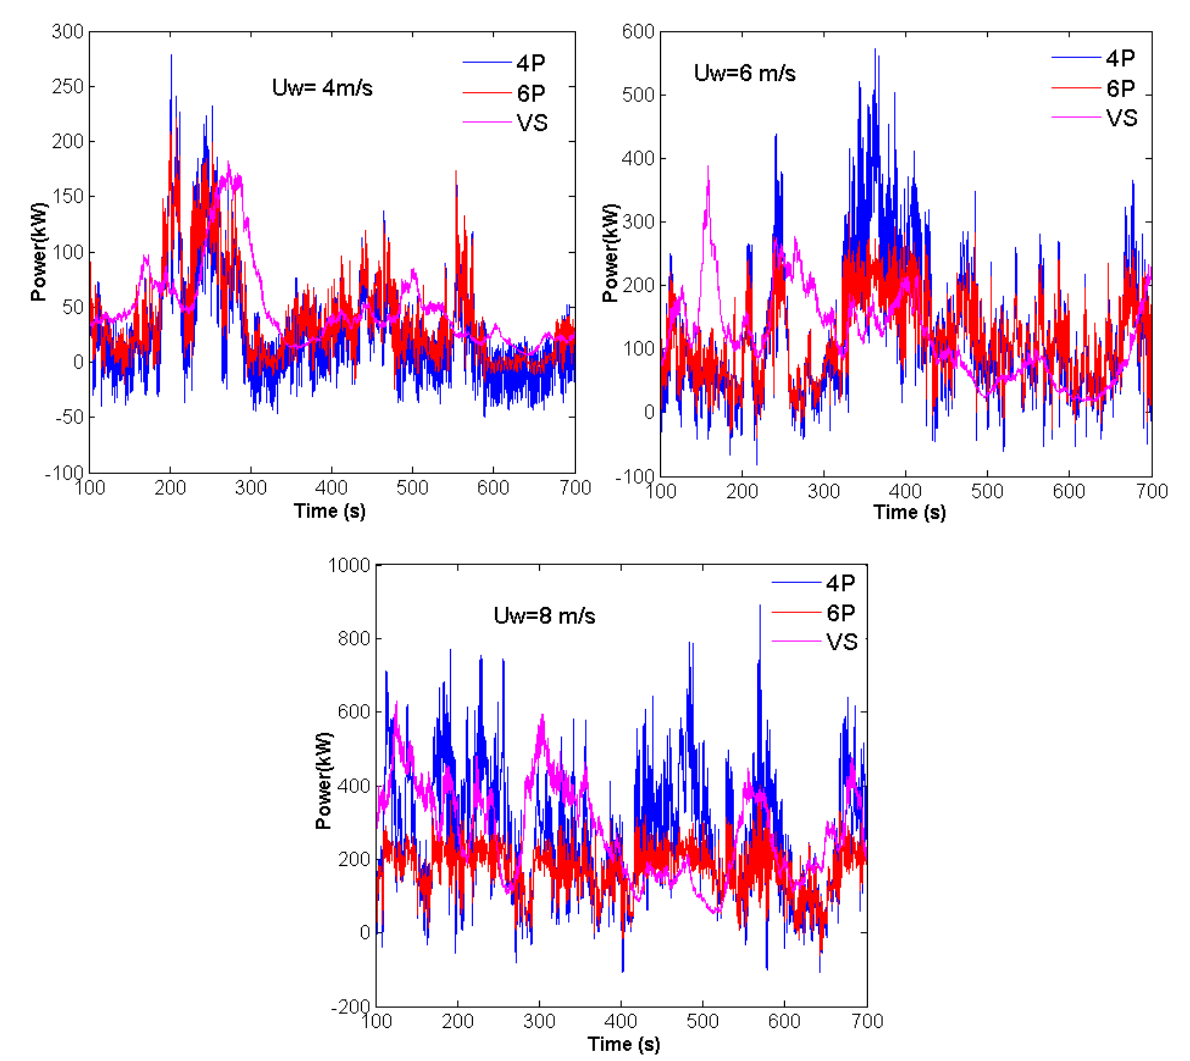
Figure 12. Power curves at different wind speeds using different